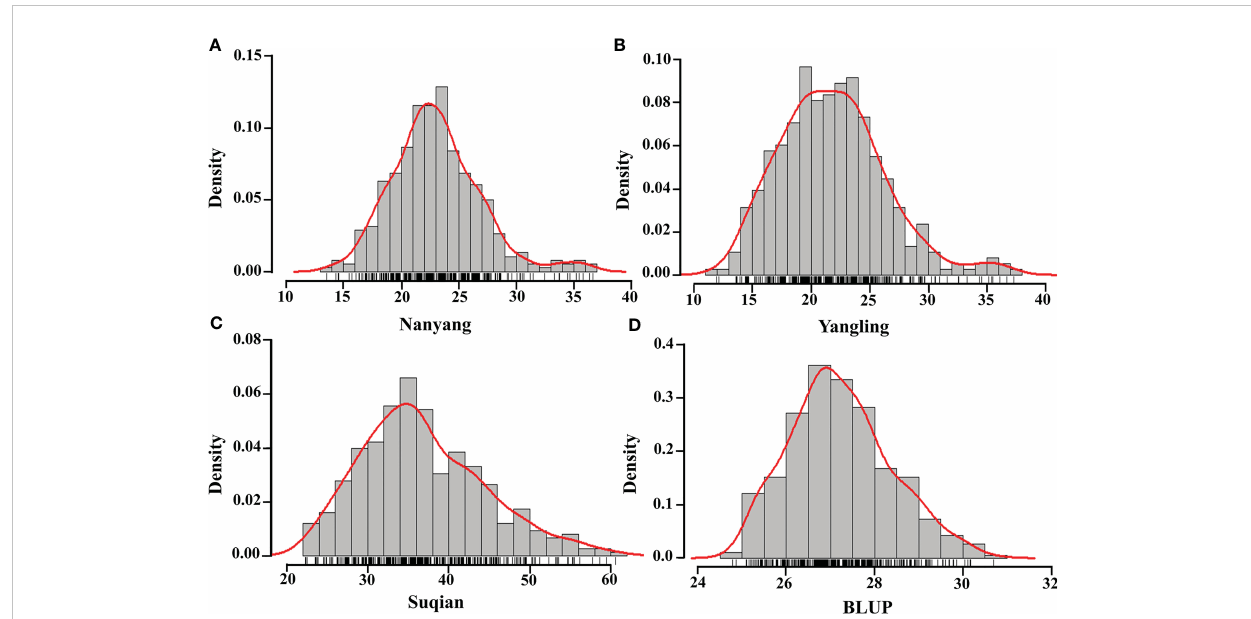
FIGURE 1 Histogram of wheat GZnC density in three environments and BLUP. Nanyang (A) , Yangling (B) , Suqian (C) , BLUP (D) , and the red curves and the black short horizontal lines represent the density curve and the rug plot of the distribution of